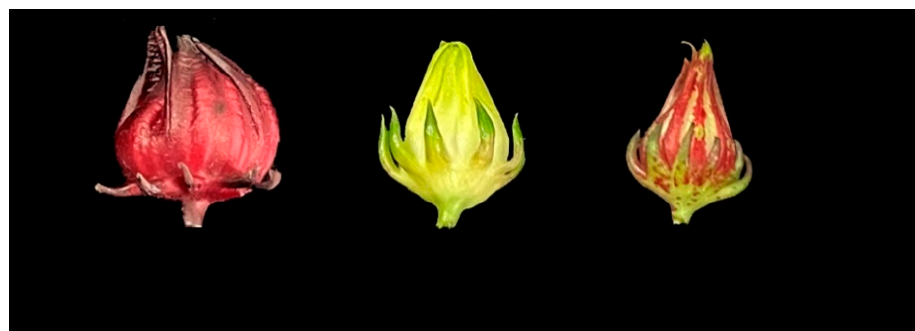
Figure 1. Represent images of calyx from the three roselle cultivars: FZ-72 ( the left ), Baitao K ( the middle ) and MG5 ( the right ). Table 1. Anthocyanin contents among different